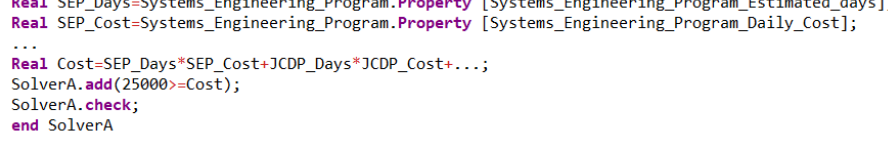
Figure 8. KARMA language for analyzing the static cost